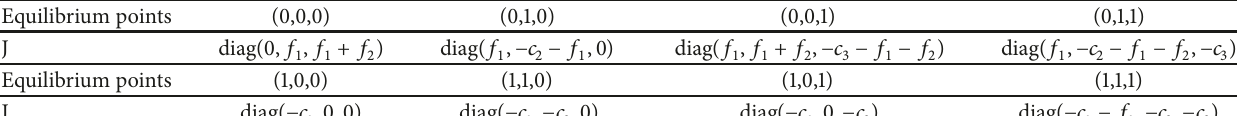
Table 1: Jacobian Matrix of Equilibrium Points with Dynamical costs.